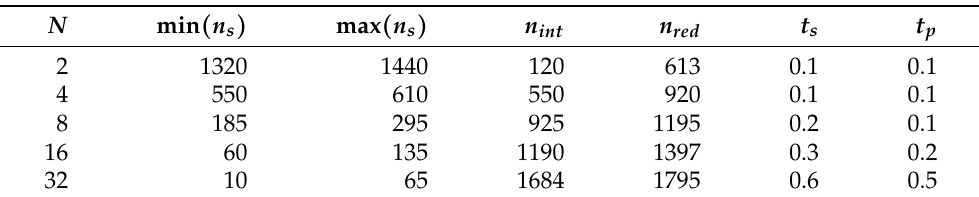
Figure 2. Example mesh, Cylindrical Shell. Table 2. Reduction time [minute], Cylindrical Shell.